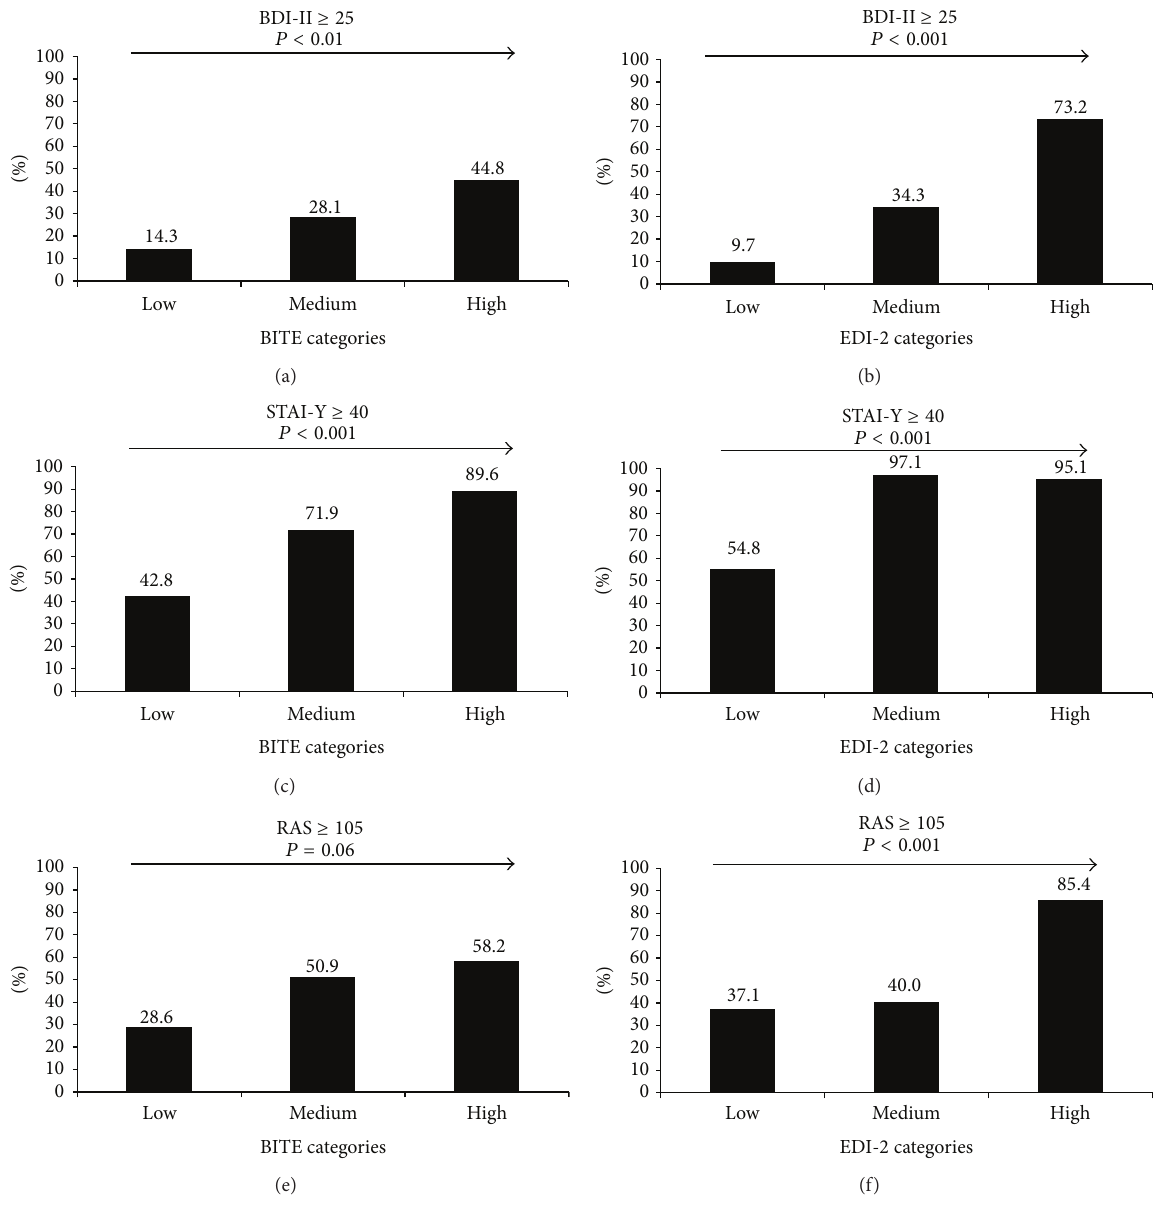
Figure 1: Psychological profile according to eating behaviour categories, as assessed by the Bulimic Investigatory Test of Edinburgh (BITE) symptoms score, and to ineffectiveness groups, as assessed by the Eating Disorder Inventory-2 (EDI-2). Results are expressed as percentage. BDI-II: Beck Depression Inventory II; STAI-Y: Spielberger State-Trait Anxiety Inventory, form Y; RAS: Rathus Assertiveness Schedule. Statistical analyses were performed using Cochran-Armitage trend test for qualitative variables and analysis of variance for quantitative